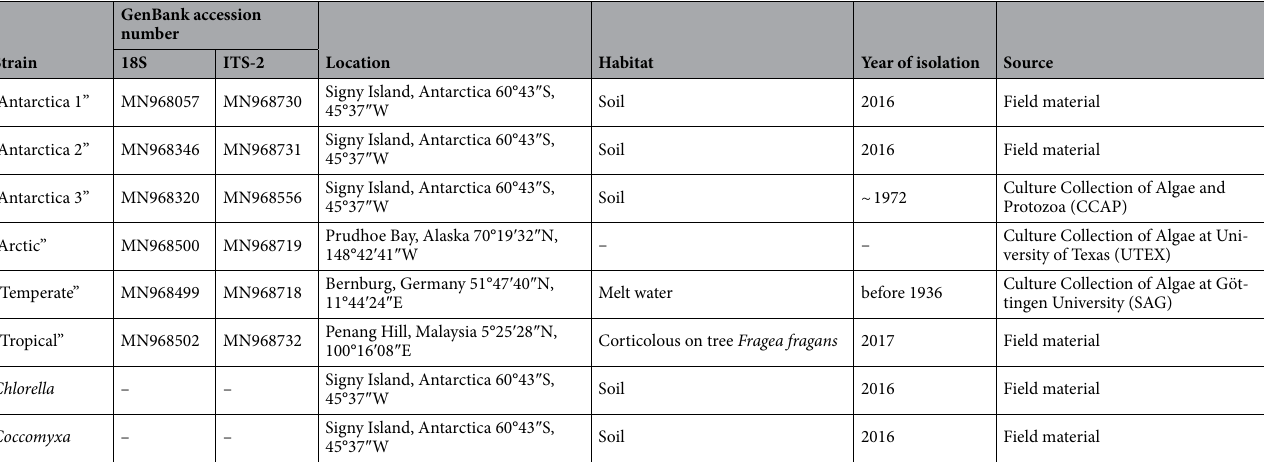
Table 2. Original collection localities of the six Stichococcus -like algal strains and the two control algae used in this